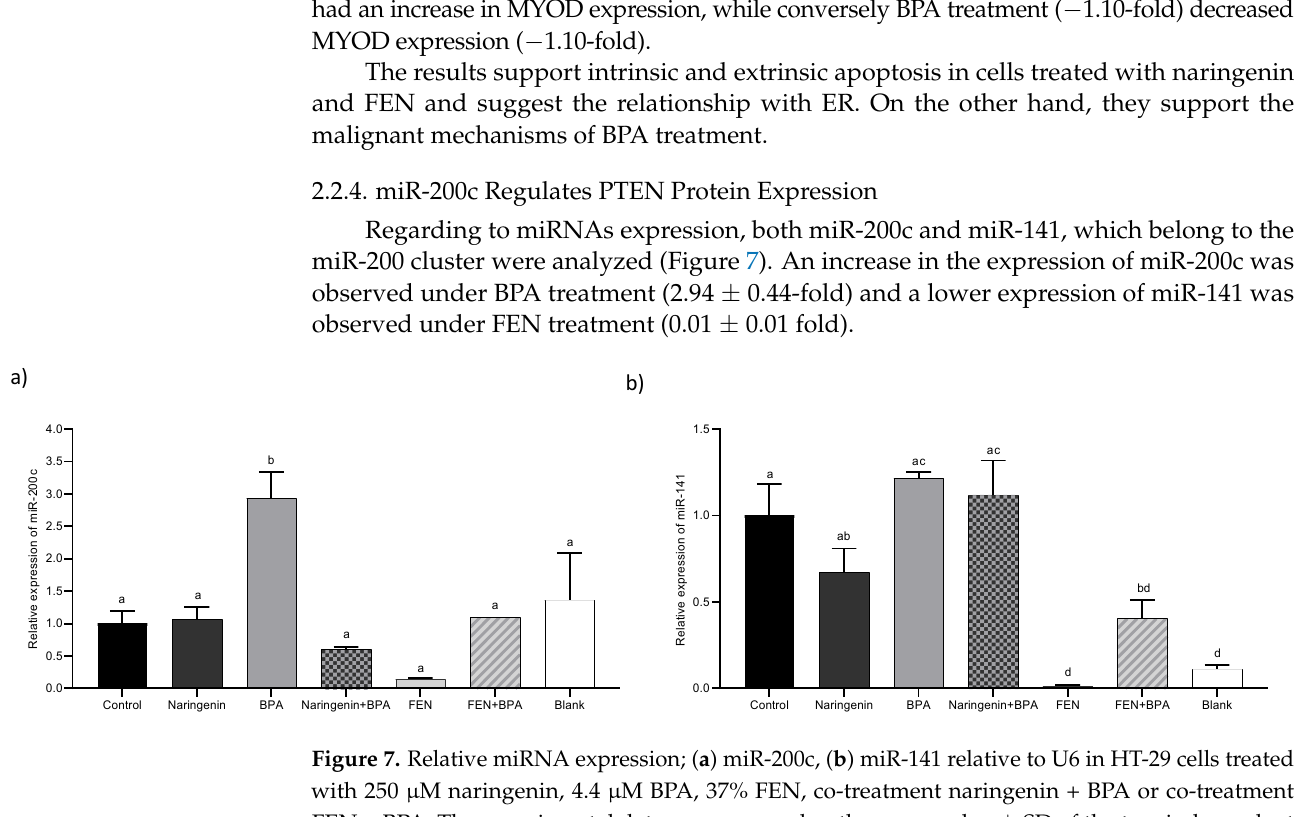
Figure 7. Relative miRNA expression; ( a ) miR-200c, ( b ) miR-141 relative to U6 in HT-29 cells treated with 250 µM naringenin, 4.4 µM BPA, 37% FEN, co-treatment naringenin + BPA or co-treatment FEN + BPA. The experimental data are expressed as the mean value ± SD of the two independent experiments. Letters indicate statistical difference by Tukey–Kramer’s Test ( p < 0.05).